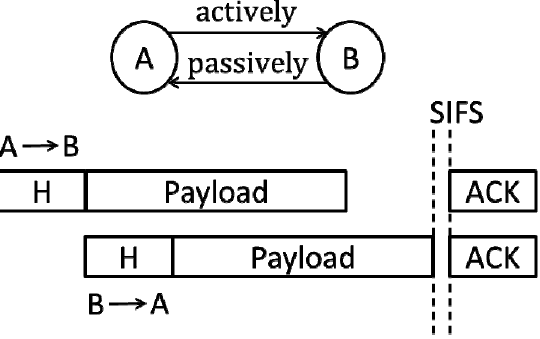
Figure 2. B obtains the MAC address of A from the received frame’s header and sends a frame to A (FD_1 mode).